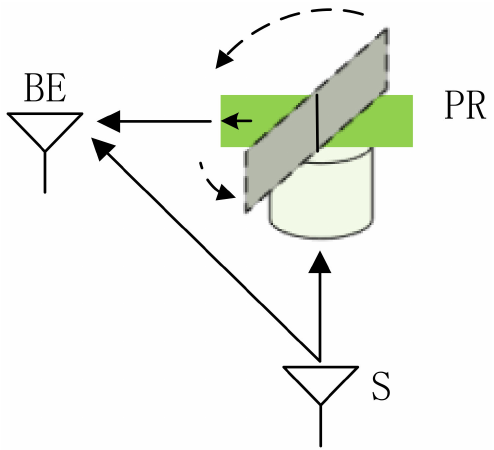
Figure 22. The physical object of the environmental backscatter tag antenna.